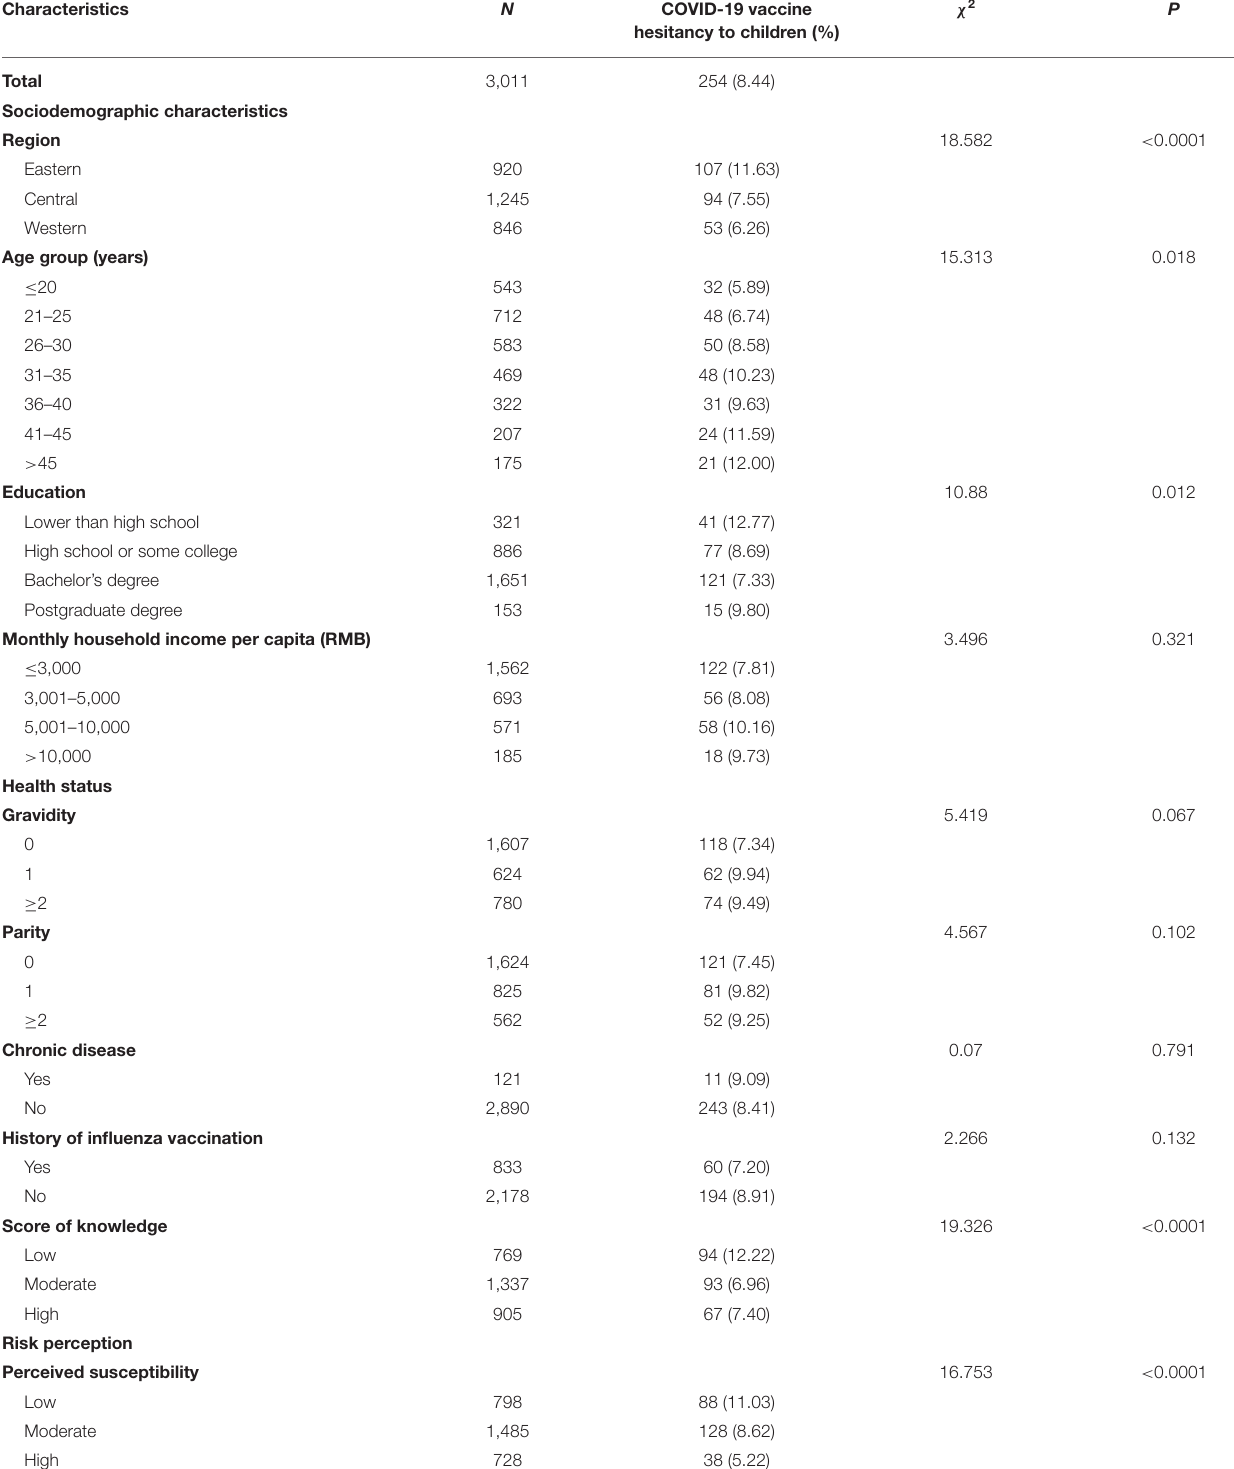
χ 2 P hesitancy to children (%) 254 (8.44)